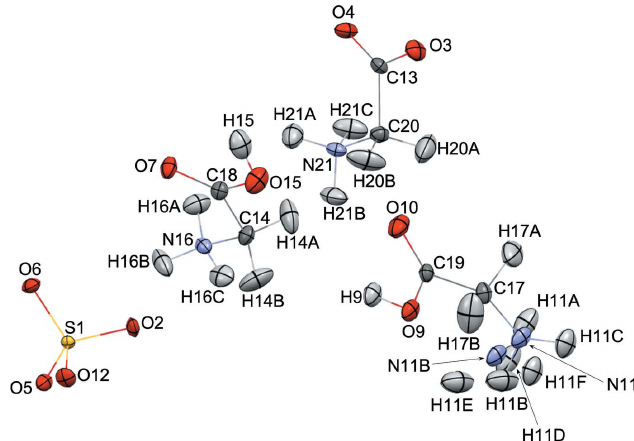
Figure 3 The molecular structure of HTGS at 298 K (model 1) showing 50% + y , 1 (cid:3) z , 2 displacement ellipsoids for all atoms.